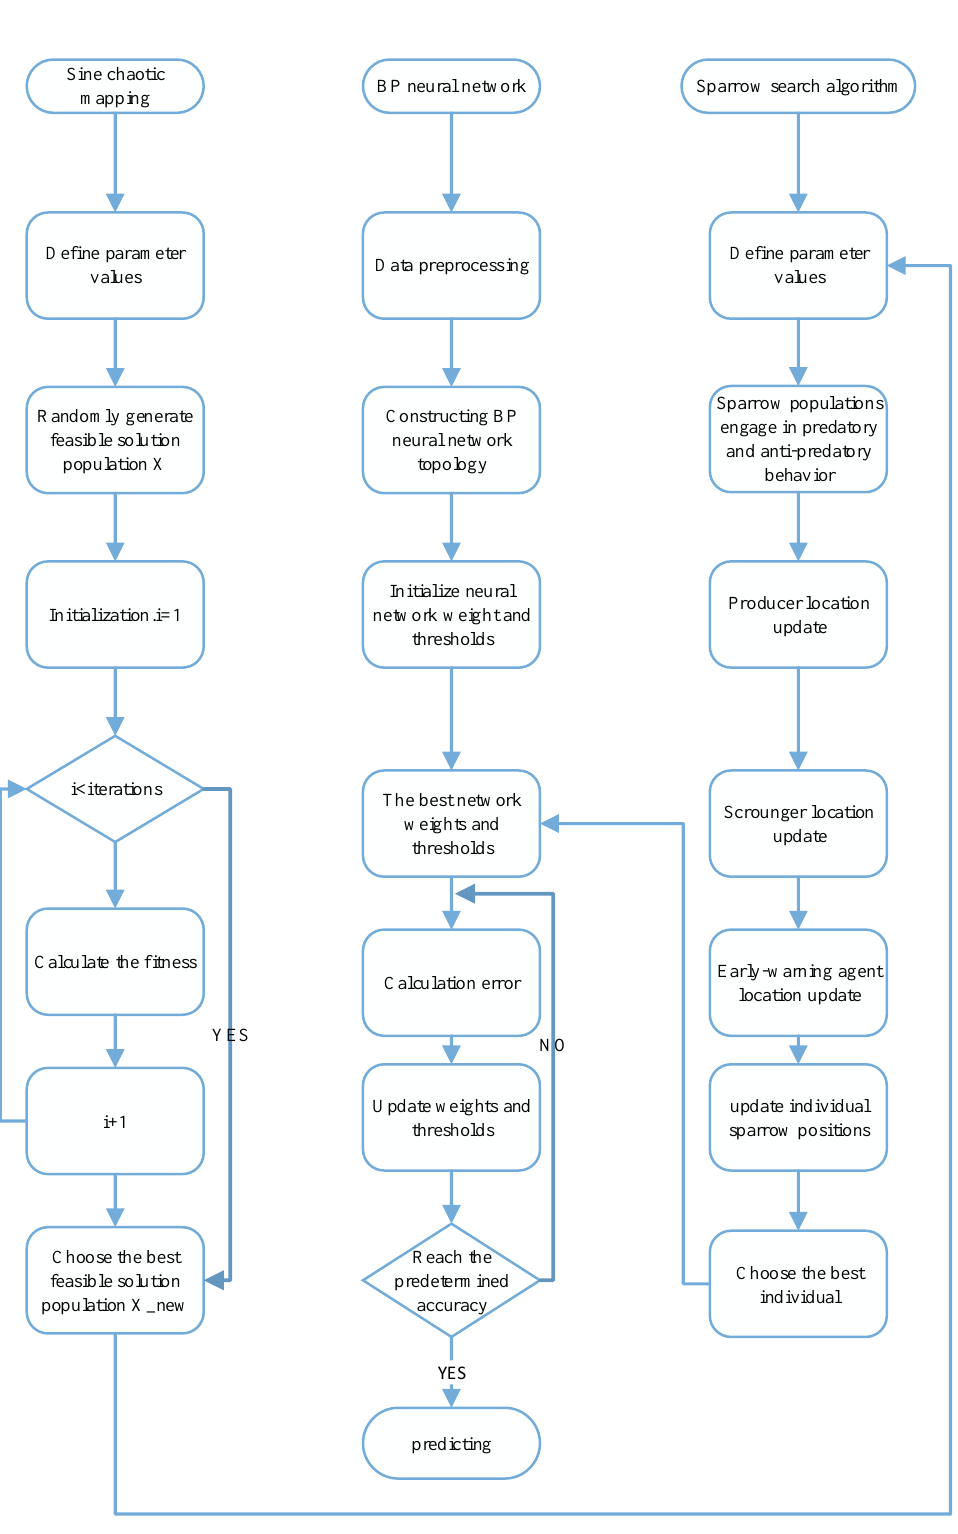
Figure 6. Sine-SSA-BP model framework